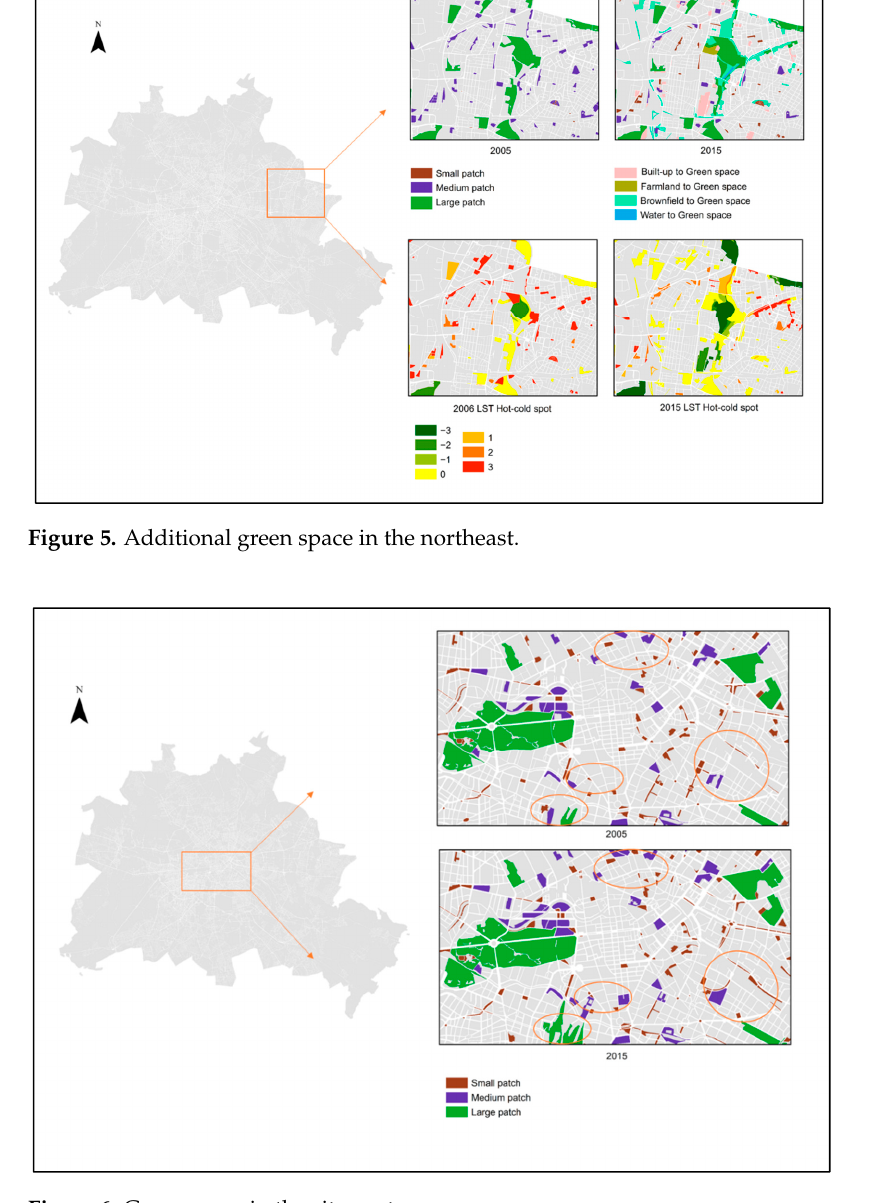
Green space in the city